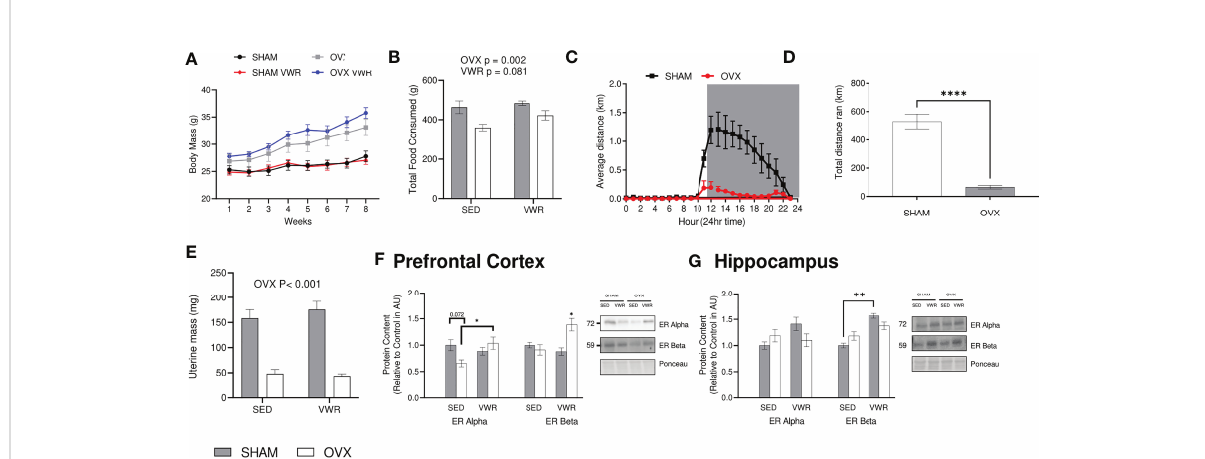
FIGURE 1 Model characteristics and con fi rmation of estrogen loss: (A) Weekly body mass during the study time (g). (B) Total food intake/cage (g). (C) Average distance ran (km) per hour. (D) Total distance ran voluntarily throughout entire study (km). (E) Uterine weight (g). (F) Prefrontal Cortex ER Alpha and ER Beta content. (G) Hippocampus ER Alpha and Er Beta content. All graphs are accompanied by representative blots. Data analyzed using a two-way ANOVA. ER Alpha, estrogen receptor alpha; ER Beta, estrogen receptor beta; SED, sedentary; VWR, voluntary wheel running; OVX, ovariectomized; SHAM, sham operated. Signi fi cance is set to *P ≤ 0.05; **P ≤ 0.005; ***P ≤ 0.0005; P ≤ 0.05; n=10 per